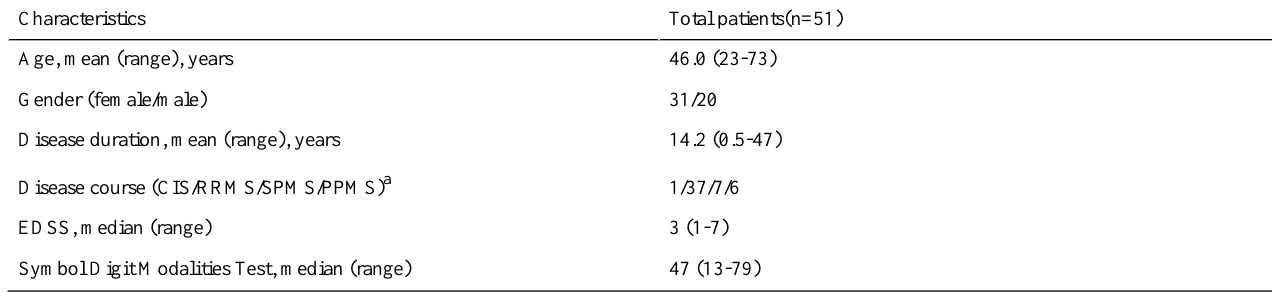
Table 3. Study patient characteristics.